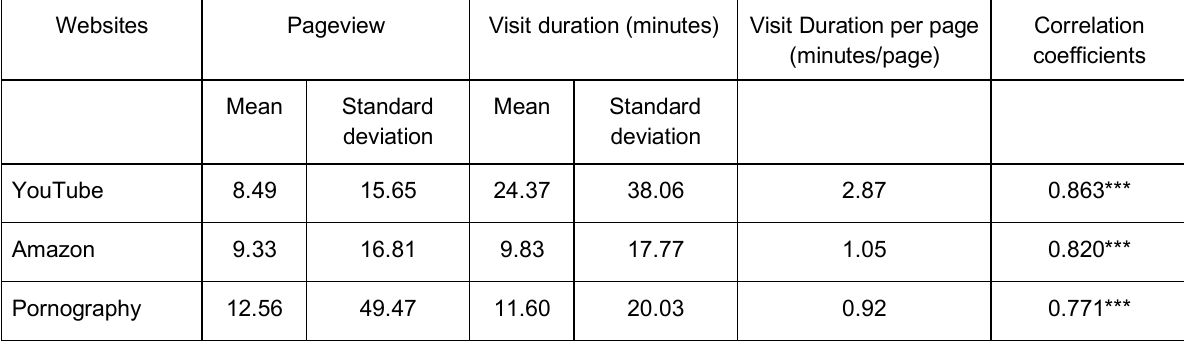
Table 5: Pageview, visit duration and its correlation coefficients: Amazon.com and YouTube.com